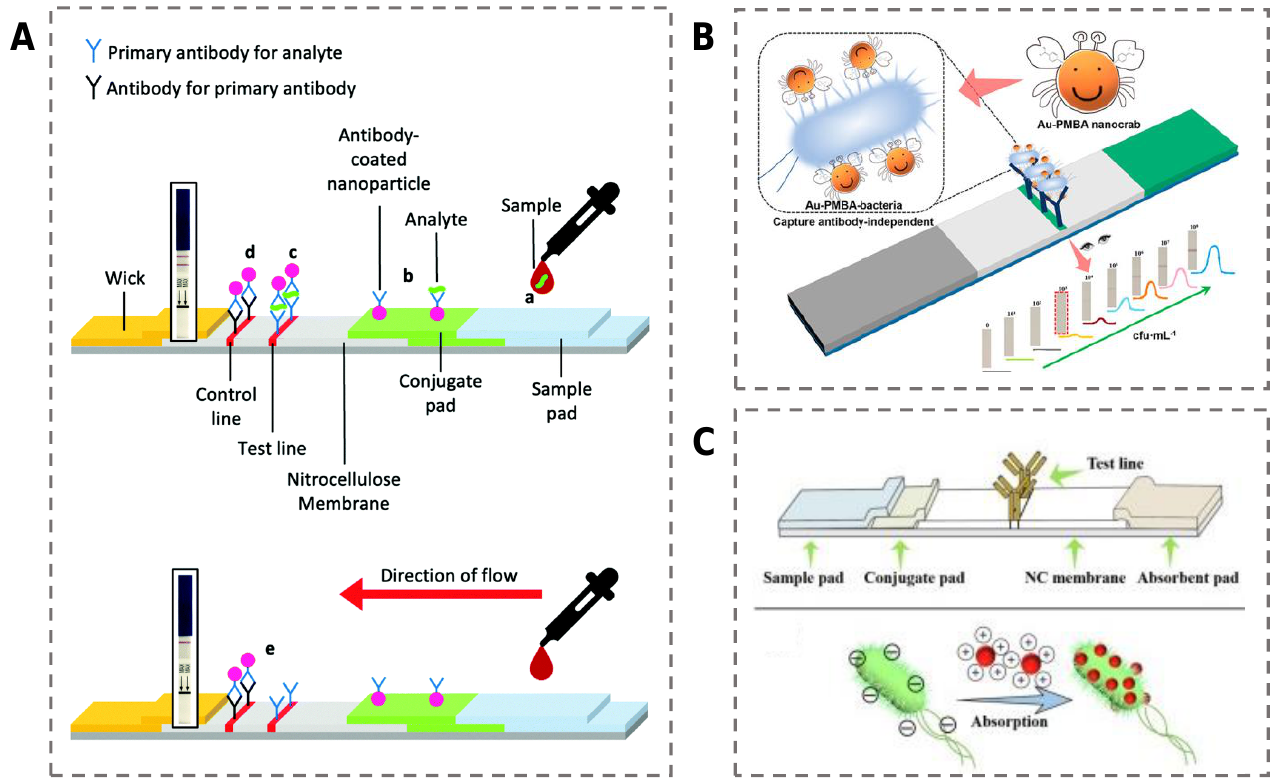
Figure 4. ( A ) Schematic of a prototypical LFA device. The device constituents in a successful positive test and a successful negative test. Reproduced with permission [82]. Copyright 2022, Royal Society of Chemistry. ( B ) A capture-antibody-independent LFA strategy based on PMBA–AuNPs for pathogen detection. Reproduced with permission [86]. Copyright 2022, American Chemical Society. ( C ) A label-free immunoassay LFA device with (+)AuNPs for S. enteritidis detection. Reproduced with permission [87]. Copyright 2019, Elsevier.